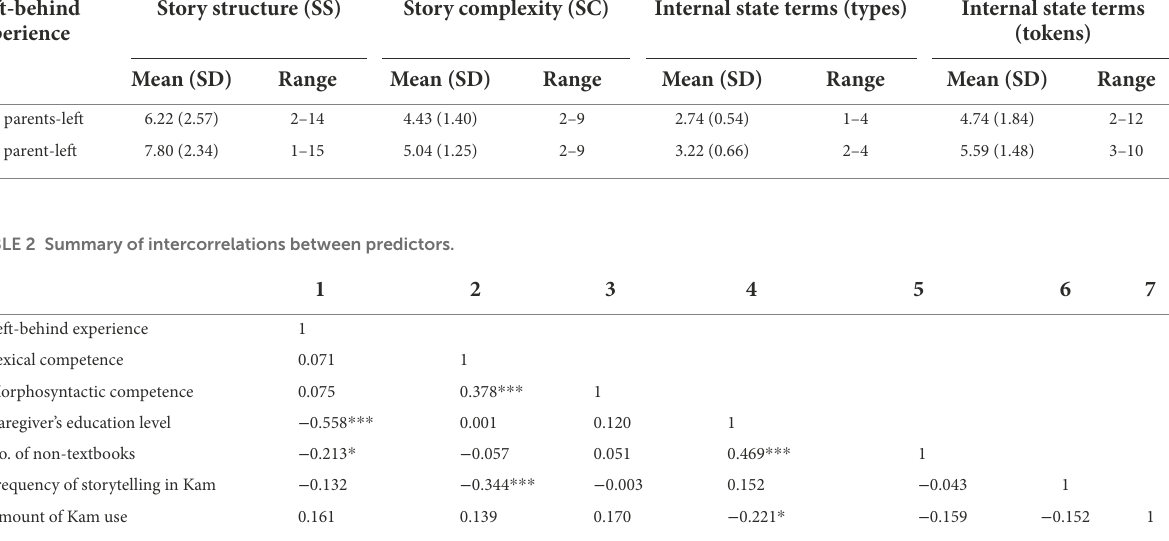
TABLE 1 Descriptive statistics of children’s scores in each outcome measure of macrostructure competence (mean (SD) and score range). Left-behind